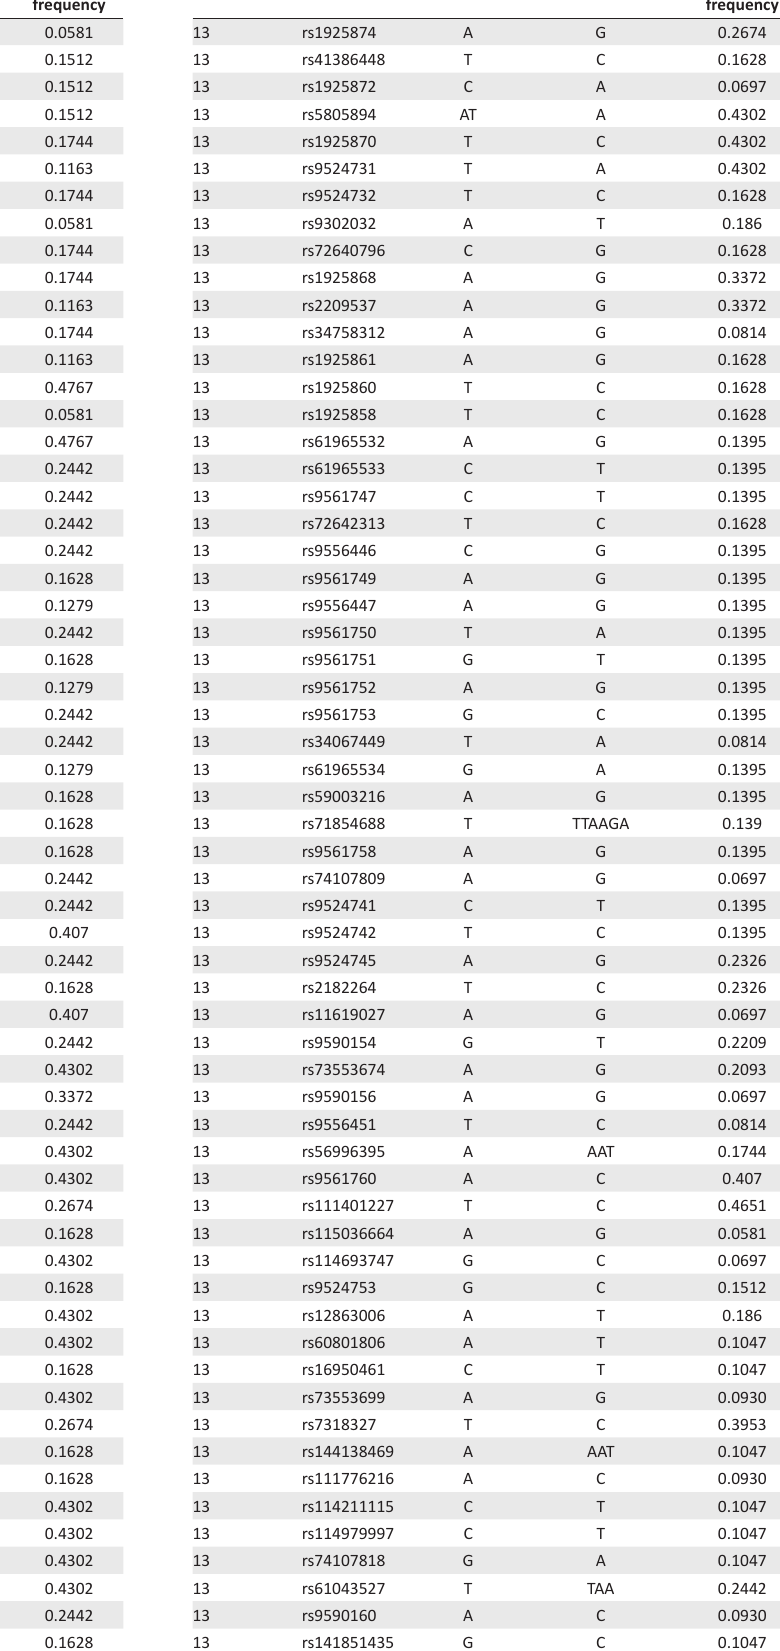
Table 1-A1 (Continues...): Minor allele frequencies for 1846 polymorphisms in 43 black South Africans. Chromosome Polymorphism Minor allele